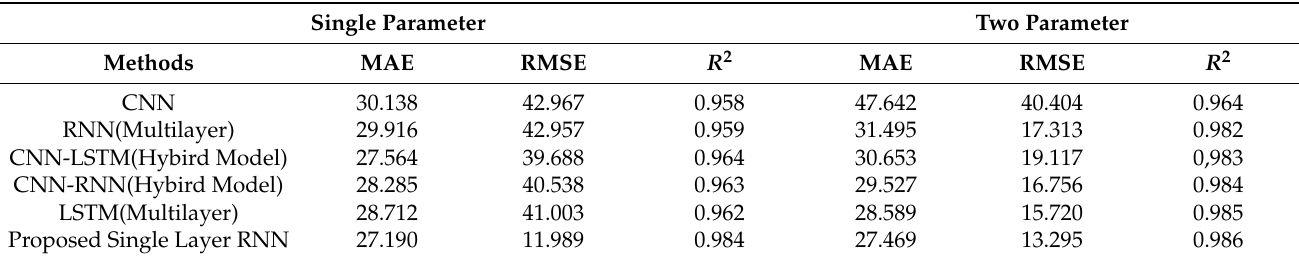
Table 7. Performance comparison of single parameter and two